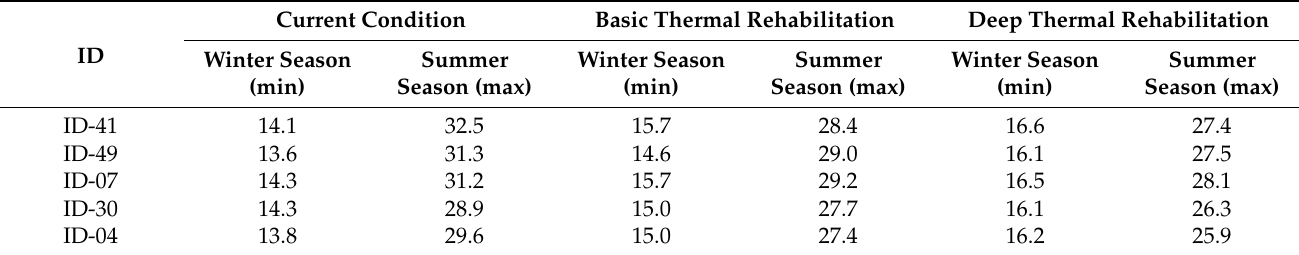
Table 10. Minimum and maximum operative temperatures ( ◦